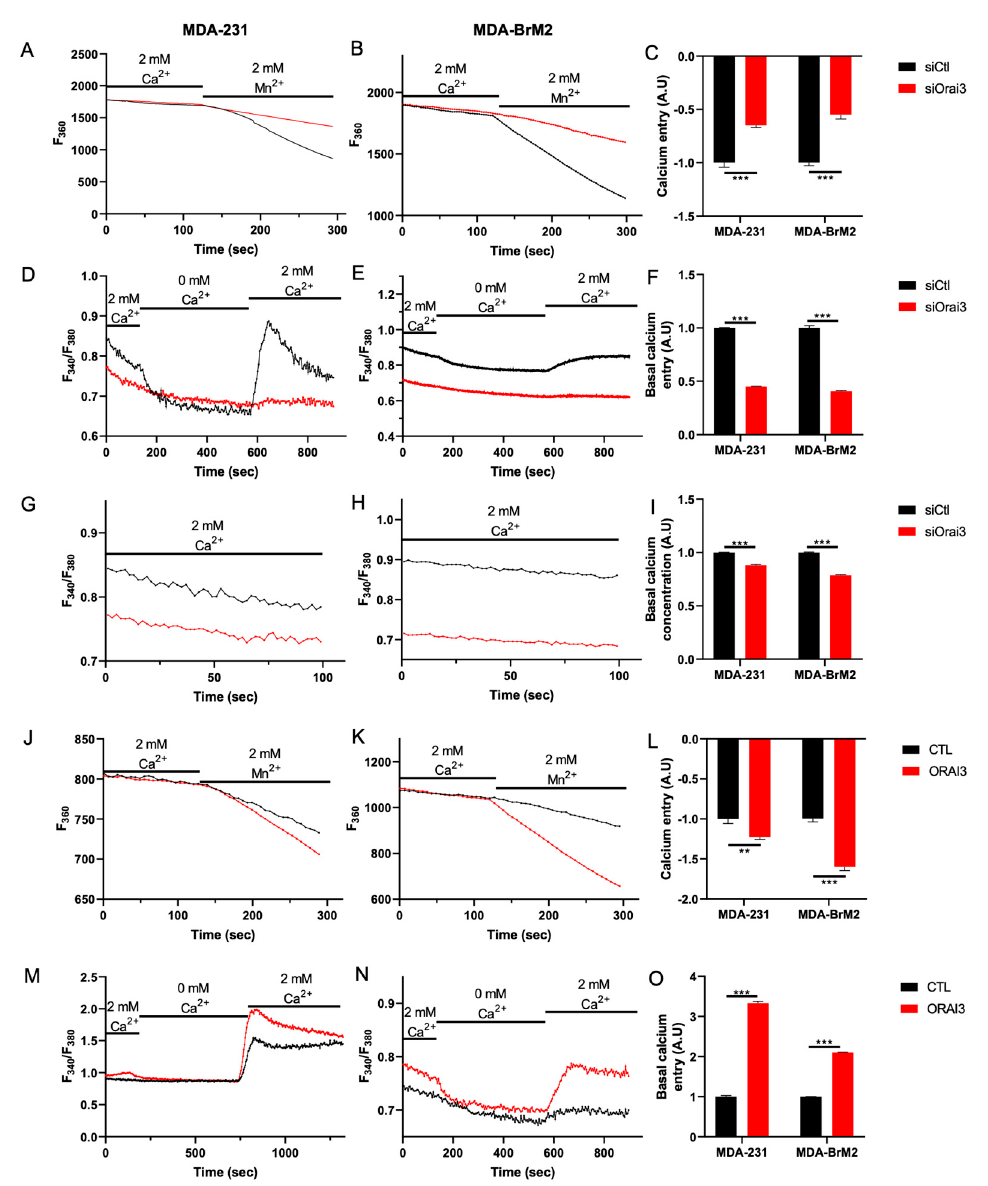
Figure 2. Orai3 is active at a basal level and modulates the intracellular Ca 2+ concentration. ( A–C) . Traces ( A , B ) and quantification ( C ) of Mn 2+ quenching measured at F 360 in MDA-231 ( A , C ) and MDA-BrM2 ( B , C ) cell lines transfected with siCtl or siOrai3 (MDA-231 siCtl n = 152; MDA-231 siOrai3 n = 162; MDA-BrM2 siCtl n = 212; MDA-BrM2 siOrai3 n = 228; N = 3; *** p < 0.001). ( D – F ). Traces ( D , E ) and quantification ( F ) of basal Ca 2+ entry measured by the calculation of the F 340 /F 380 in MDA-231 ( D , F ) and MDA-BrM2 ( E , F ) cell lines transfected with siCtl or siOrai3 (MDA-231 siCtl n = 269; MDA-231 siOrai3 n = 255; MDA-BrM2 siCtl n = 222; MDA-BrM2 siOrai3 n = 322; N = 3; *** p < 0.001). ( G – I ). Ca 2+ concentration plot ( G , H ) and quantification ( I ) measured by the calculation of the F 340 /F 380 in MDA-231 ( G , I ) and MDA-BrM2 ( H , I ) cell lines transfected with siCtl or siOrai3 (MDA-231 siCtl n = 423; MDA-231 siOrai3 n = 441; MDA-BrM2 siCtl n = 404; MDA-BrM2 siOrai3 n = 490; N = 3; *** p < 0.001). ( J – L ). Traces ( J , K ) and quantification ( L ) of Mn 2+ quenching measured at F 360 in MDA-231 ( J , L ) and MDA-BrM2 ( K , L ) cell lines transfected with CTL or ORAI3 (MDA-231 CTL n = 182; MDA-231 ORAI3 n = 169; MDA-BrM2 CTL n = 198; MDA-BrM2 ORAI3 n = 158; N = 3; ** p < 0.01; *** p < 0.001). ( M – O ). Traces ( M , N ) and quantification ( O ) of basal Ca 2+ entry measured by the calculation of the F 340 /F 380 in MDA-231 ( M , O ) and MDA-BrM2 ( N , O ) cell lines transfected with CTL or ORAI3 (MDA-231 CTL n = 212; MDA-231 ORAI3 n = 209; MDA-BrM2 CTL n = 188; MDA-BrM2 ORAI3 n = 199; N = 3; *** p < 0.001).